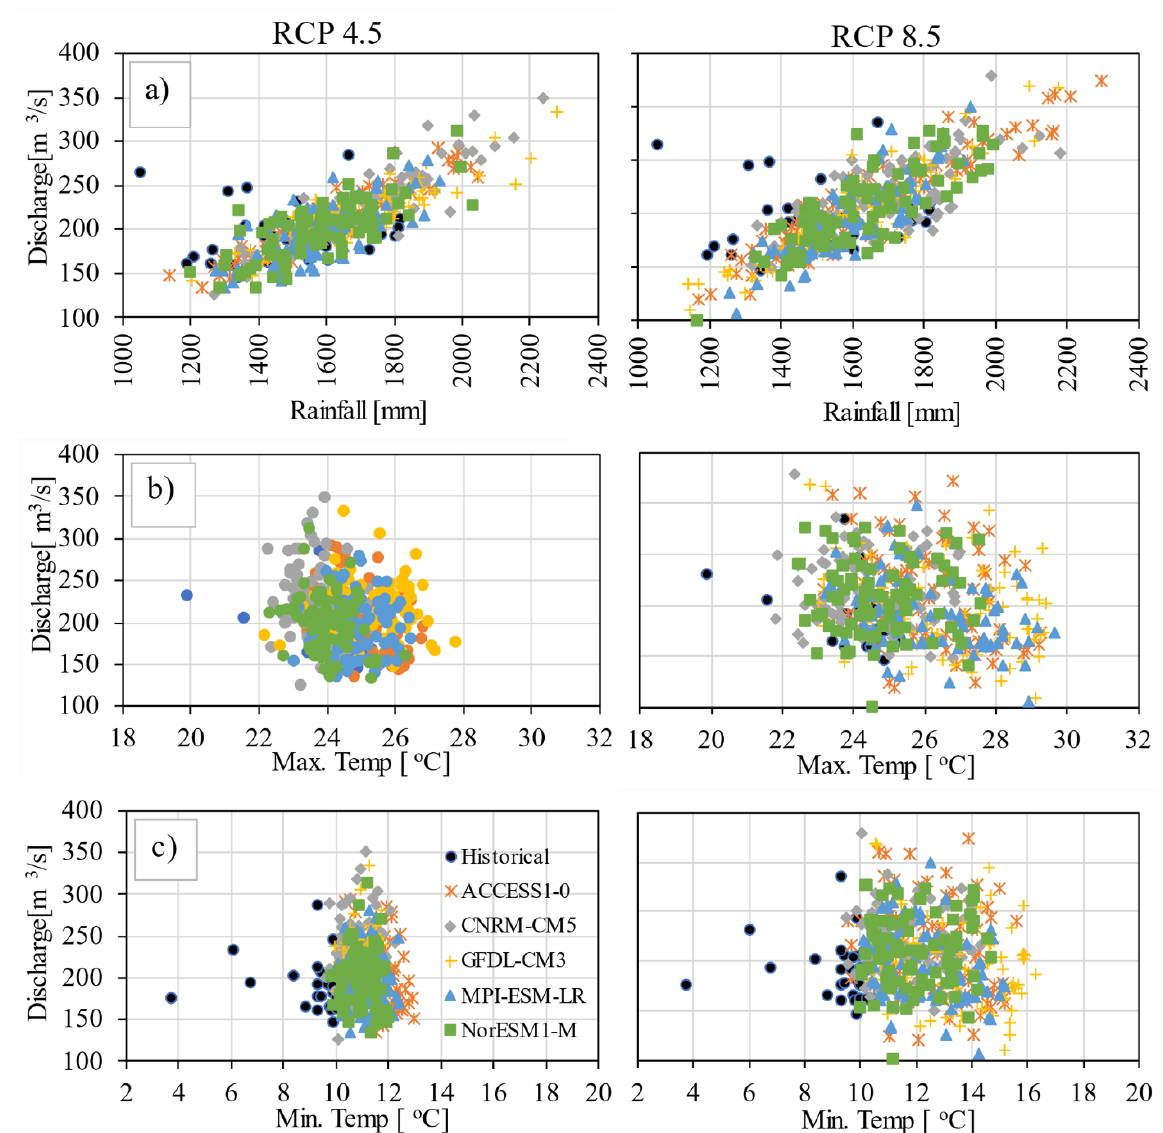
Figure 11. Relationship between ( a ) precipitation and streamflow and ( b , c ) temperature and streamflow of historical and projected values over a temporal period of 1981–2099 under RCP 4.5 ( left panel ) and RCP 8.5 ( right panel ).